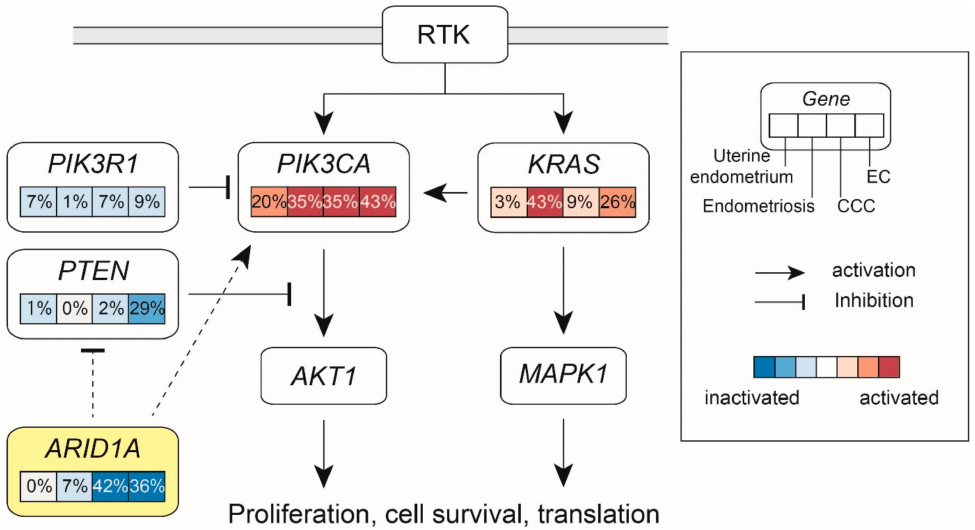
Figure 1. Alteration of PI3K/AKT and RAS/MAPK pathways in endometrium, endometriosis, and endometriosis- associated ovarian cancer